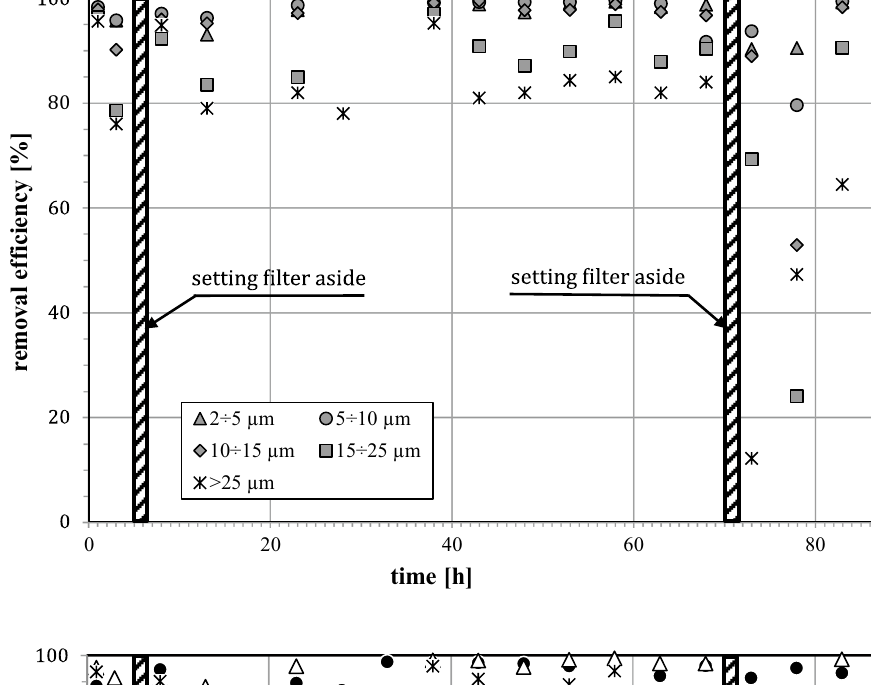
Fig. 3 Efficiency of removing turbidity, suspension concen- tration and total number